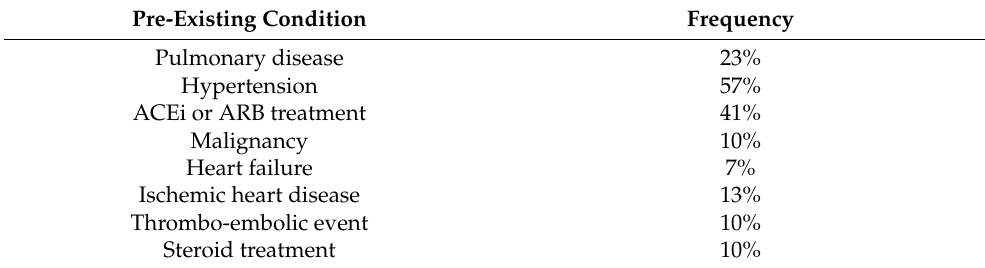
Table 1. Background data and pre-existing co-morbidities (%) among the patients. Angiotensin converting enzyme inhibitor is denoted ACEi and angiotensin receptor blocker is denoted